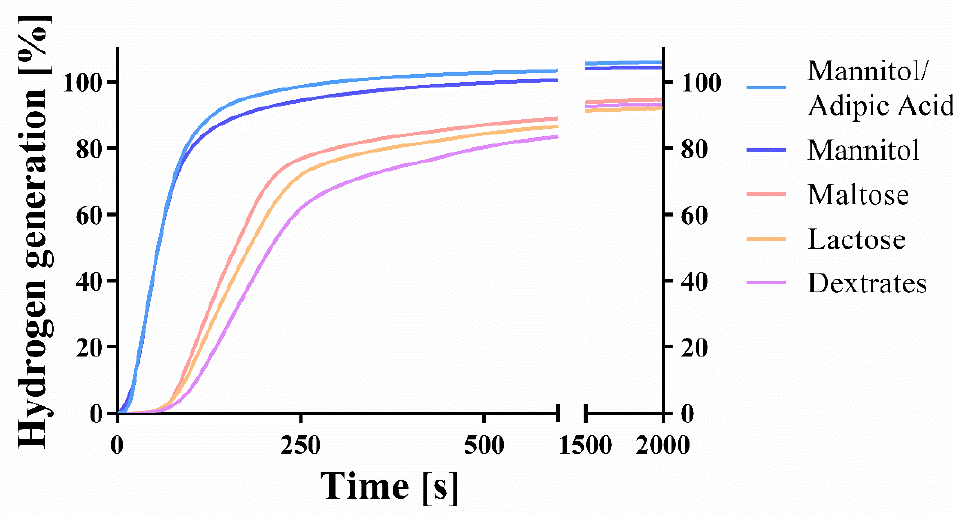
Figure 2. Kinetic hydrogen generation measurement (means; n = 3). Kinetics of hydrogen generation were measured using different fillers and lubricants. Means were calculated and plotted against time. SD values can be found in Table 1.